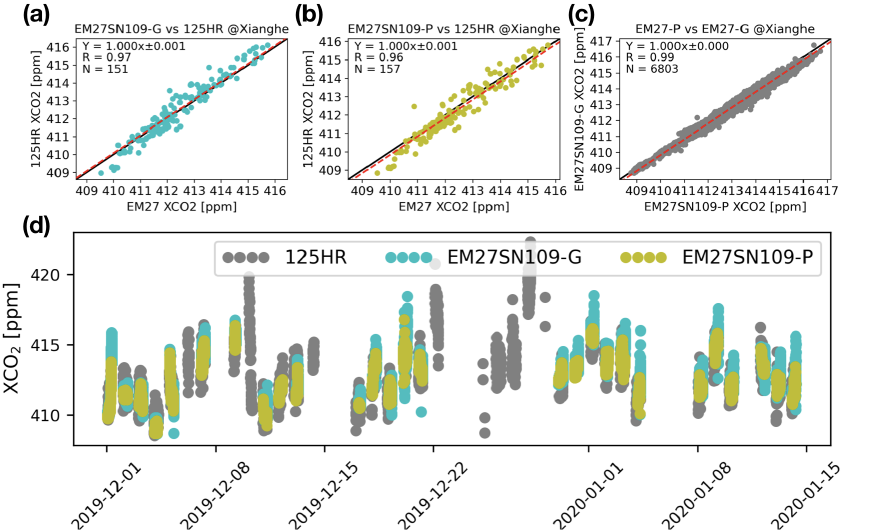
Figure 4. The scatter plots between the Bruker 125HR (TCCON) and the Bruker EM27/SUN SN109 co-located XCO 2 hourly means retrieved by the GGG2020 code ( a ) and by the PROFFAST code ( b ) in Xianghe. The scatter plots between the Bruker EM27/SUN SN109 individual XCO 2 retrieved by the GGG2020 code and by the PROFFAST code ( c ). The red dashed line is the linear fitting ( y = ax ). R is the Pearson correlation coefficient. N is the number of co-located data. The time series of the Bruker 125HR (TCCON) XCO 2 measurements and the Bruker EM27/SUN SN109 measurements retrieved by the GGG2020 and PROFFAST v1.0 codes between December 2019 and January 2020 ( d